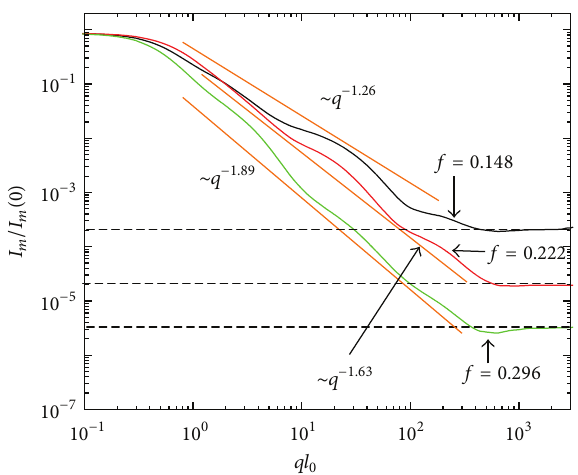
Figure 3: The monodisperse structure factor for the fragmentation model at various values of probability 𝑓 shows a superposition of maxima and minima on a simple power-law decay in the fractal region.Thecurvesareshifteddownverticallyforclaritywithafactor of 10 − 2 (red; middle curve) and, respectively, with 10 − 4 (green; lower curve). Iteration number is 𝑚 = 6.